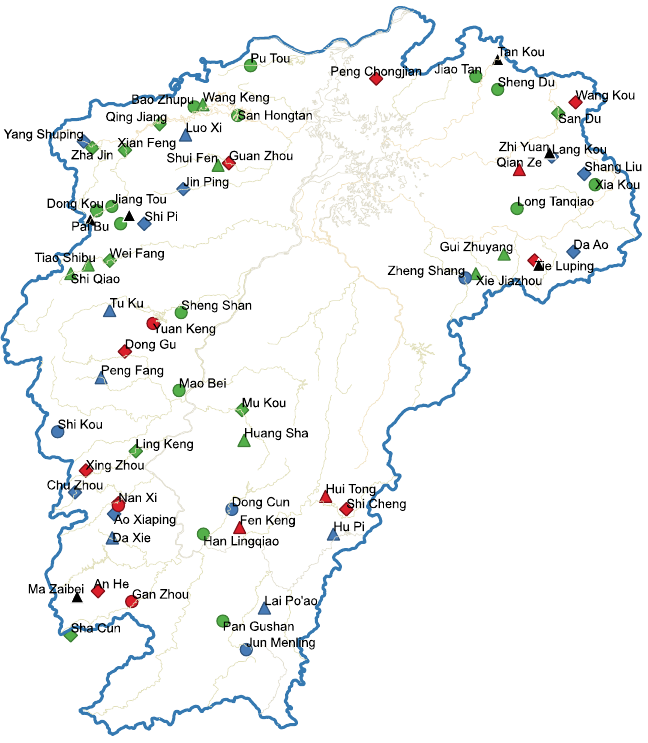
Figure 9. The clustering results of clustering ensemble